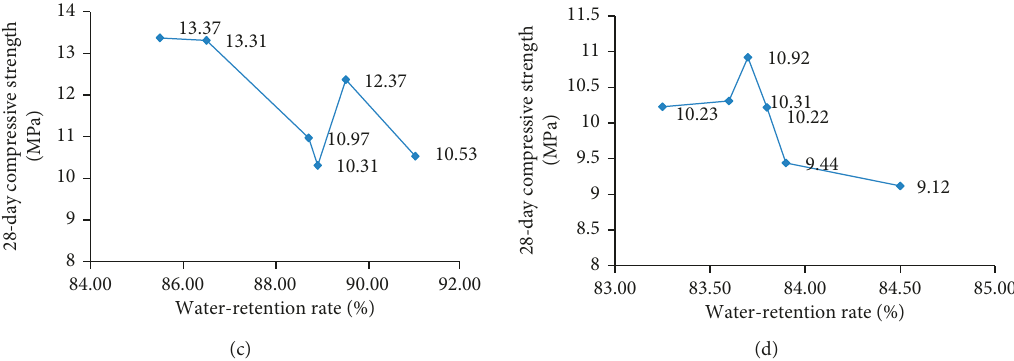
Figure 11: Change of the 28-day compressive strength of mortar with the increase of water-retention rate. (a) With cellulose ether added. (b) With starch ethers added. (c) With bentonite added. (d) With redispersion emulsoid powder